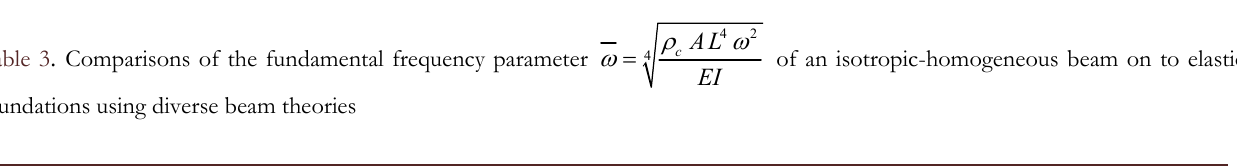
Table 3 . Comparisons of the fundamental frequency parameter of an isotropic-homogeneous beam on to